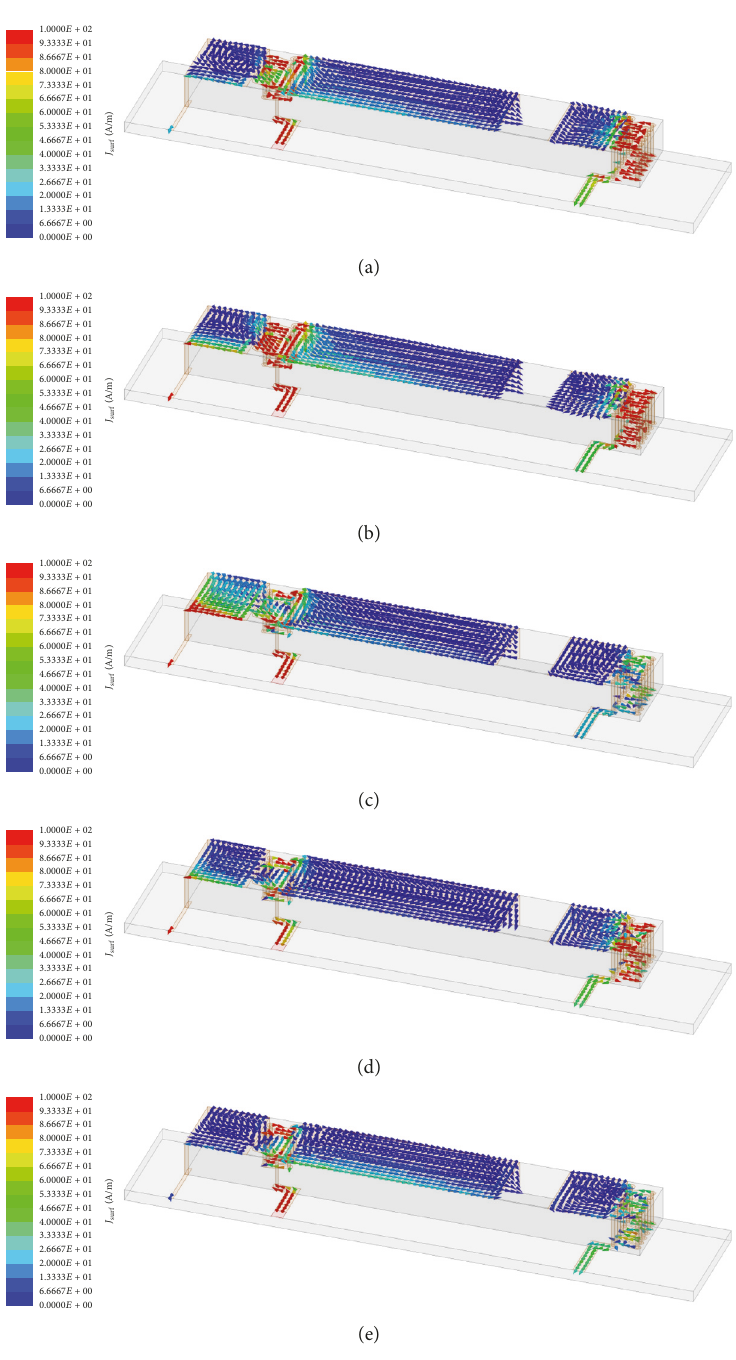
Figure 4: Simulated surface current distributions of the proposed antenna at (a) 0.82, (b) 0.92, (c) 1.78, (d) 2.08, and (e) 2.62 GHz.